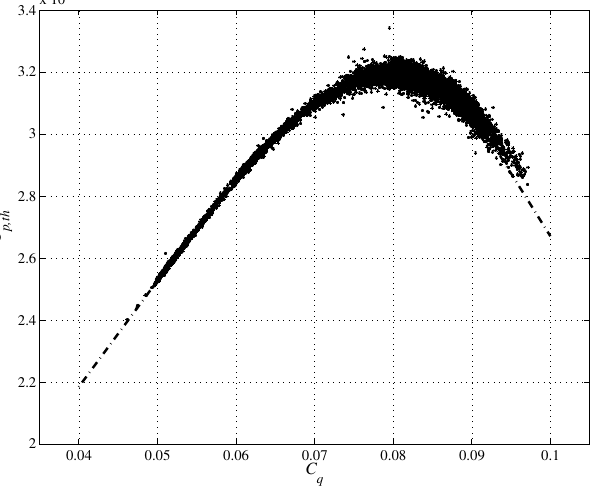
Figure 7. Dimensionless streamflow power, C p , th , vs. dimension- less flow, C q : experimental data and